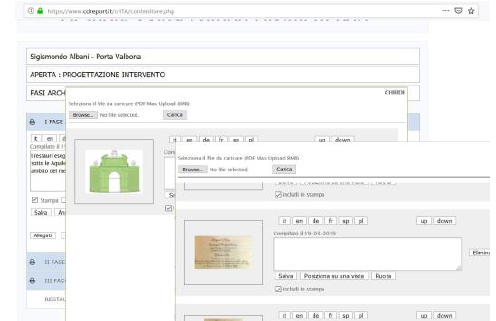
Figure 5. CDR interface: possibility to attach JPG and PDF